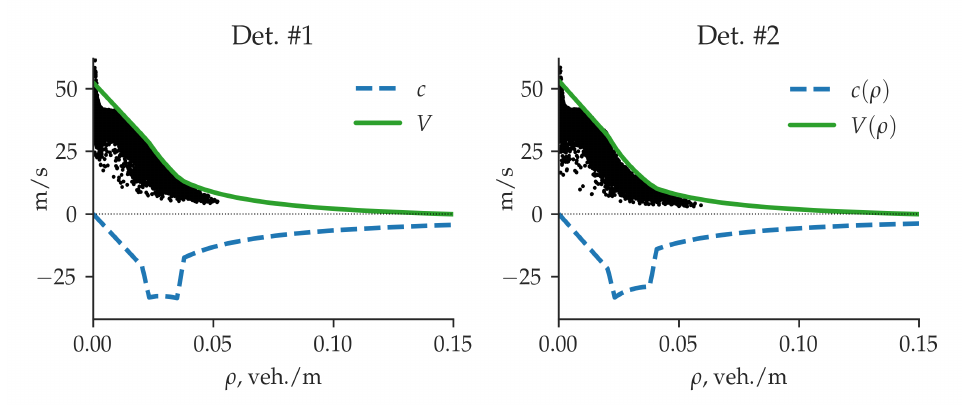
Figure 3. Equilibrium speed V ( ρ ) (solid green line) and relative velocity of the congestion propaga- ( ρ ) tion c ( ρ ) = ρ ∂ V (dashed blue line) as the functions of density for the first lane of I-580 together ∂ρ with the historic data for the one-year period. Left: detector #1, right: detector